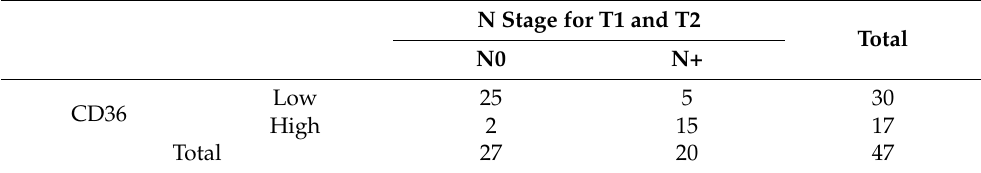
Table 6. Cross-table showing the association between CD36 expression and lymph node metastasis in T1 and T2